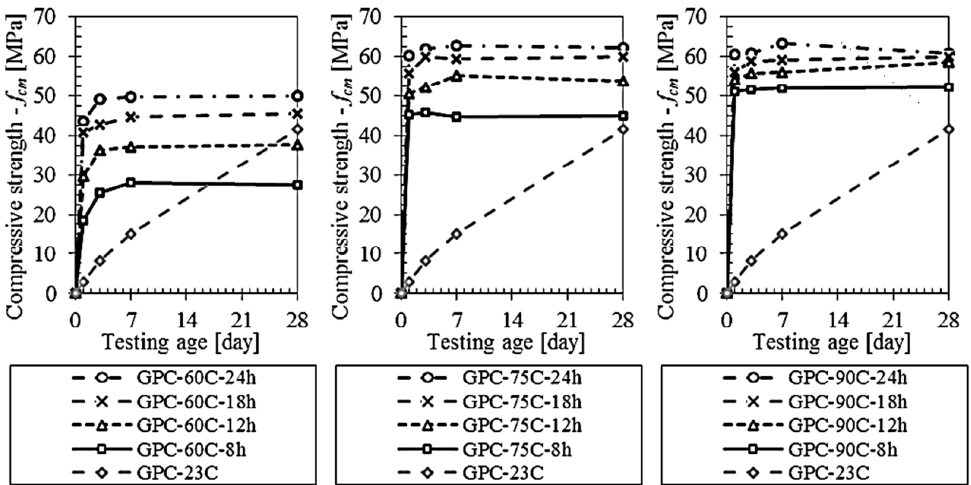
Figure 18. Compressive strength development of ambient and heat ‐ cured GP concretes. Adapted from [144].